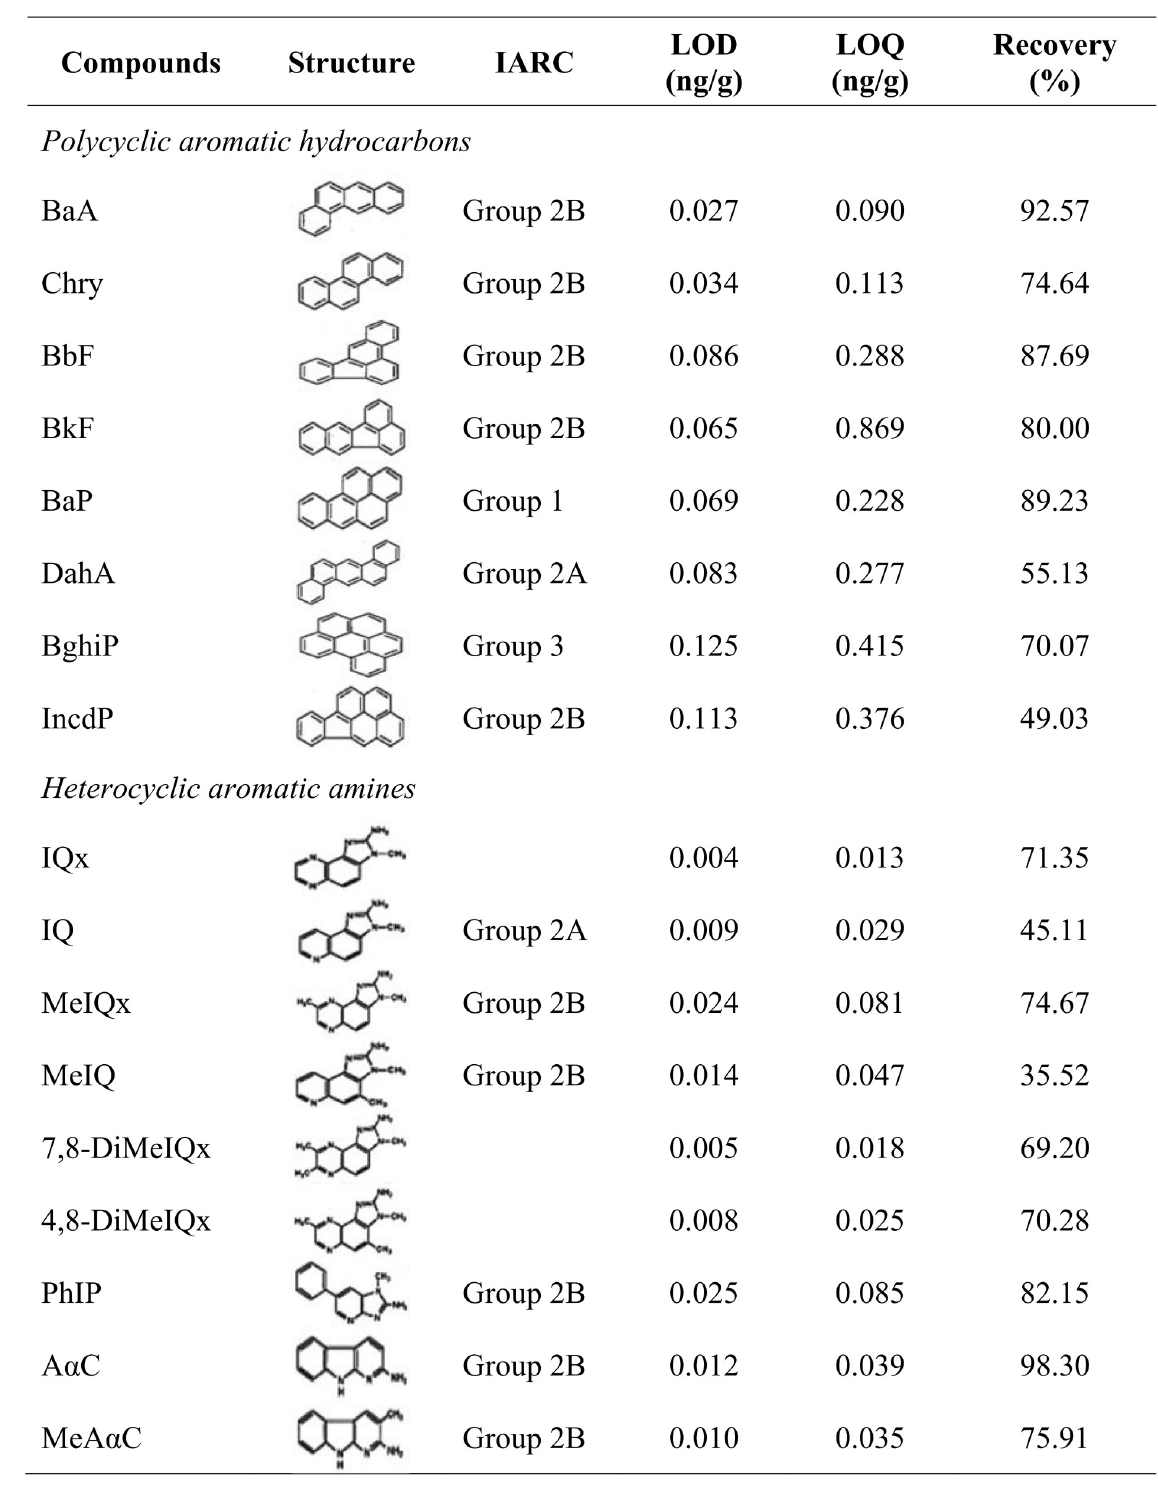
Fig 1. Limits of detection (LOD), limits of quantification (LOQ), recoveries of standard curve and percent recovery of PAH and HAA standards. IARC: International Agency for Research Cancer, Group 1: potentially carcinogenic to human, Group 2A: probably carcinogenic to humans, Group 2B: possibly carcinogenic to humans, Group 3: not classifiable as to its carcinogenicity to humans.